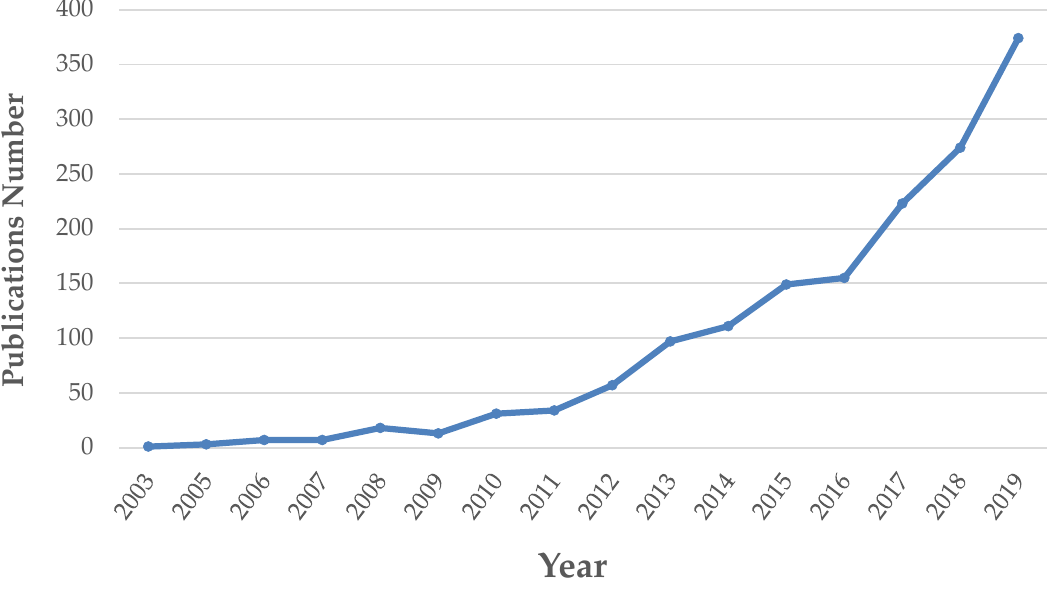
Figure 2. Increasing trend in nutraceutical publications obtained using the keywords “nutraceutical” and “metabolomics” from Scopus (https://www.scopus.com). At submission, the document count for 2020 is 84.